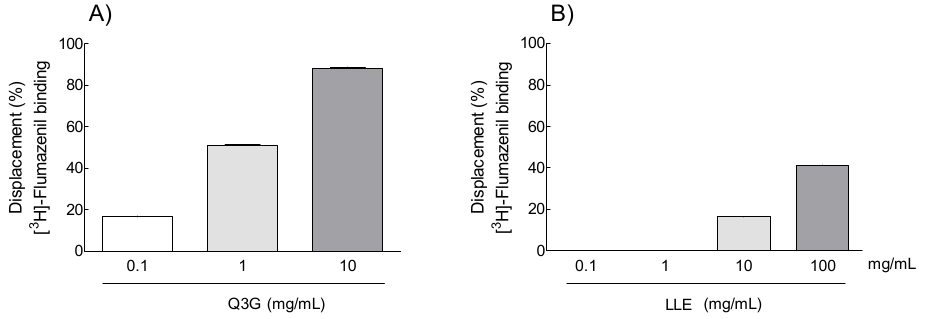
Figure 5. Dose–response displacement (%) of [ 3 H]-flumazenil binding by ( A ) quercetin-3- O -glucuronide (Q3G: 0.1, 1, and 10 mg/mL) and ( B ) the lotus leaf extract (LLE: 0.1, 1, 10, and 100 mg/mL) was analyzed by GABA A -BDZ receptor binding assay. Values are means ± standard deviation for each group.